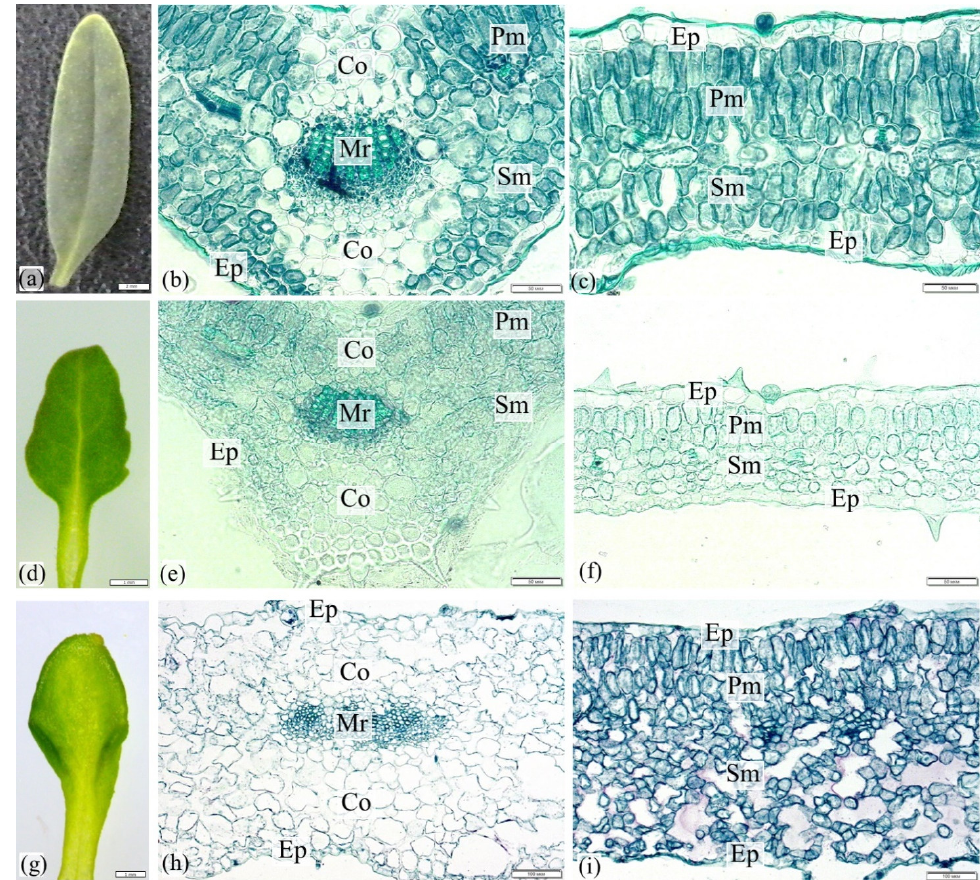
Figure 5. Morphology and anatomy of H. officinalis f. cyaneus leaf blades ex situ ( a – c ) and in vitro when cultured on a modified MS nutrient medium supplemented with 0.1 mg/l IBA and BAP at concentrations of 0.4 mg/l ( d – f ) and 0.8 mg/l ( g – i ). Co—collenchyma, Ep—epidermis, Mr—midrib, Pm—palisade mesophyll, Sm—spongy mesophyll. The epidermis with a cuticle, several subepidermal layers of collenchyma in the upper and lower parts, and an oval bundle consisting of xylem and phloem are differen- tiated on the cross sections of the midrib (Figure 5b). The collenchyma cells were adjacent to the palisade mesophyll (2–3 layers) and spongy mesophyll (3–4 layers), in which lat- eral veins were found.